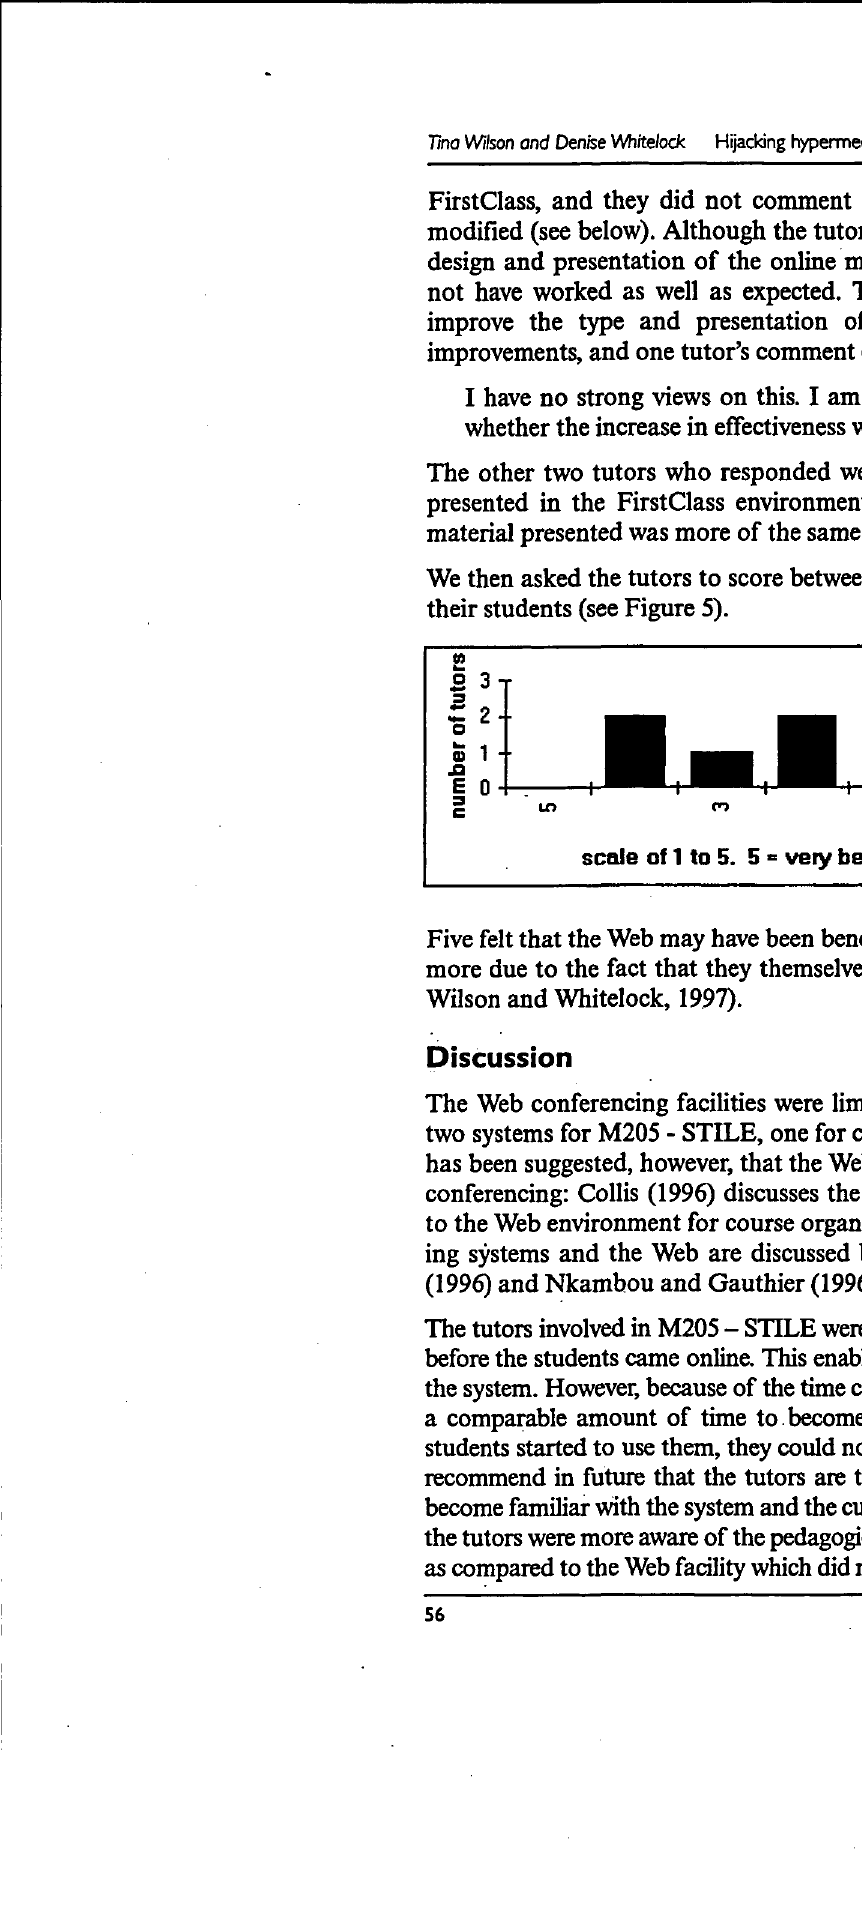
Figure 5: How beneficial tutors felt the Web was for their